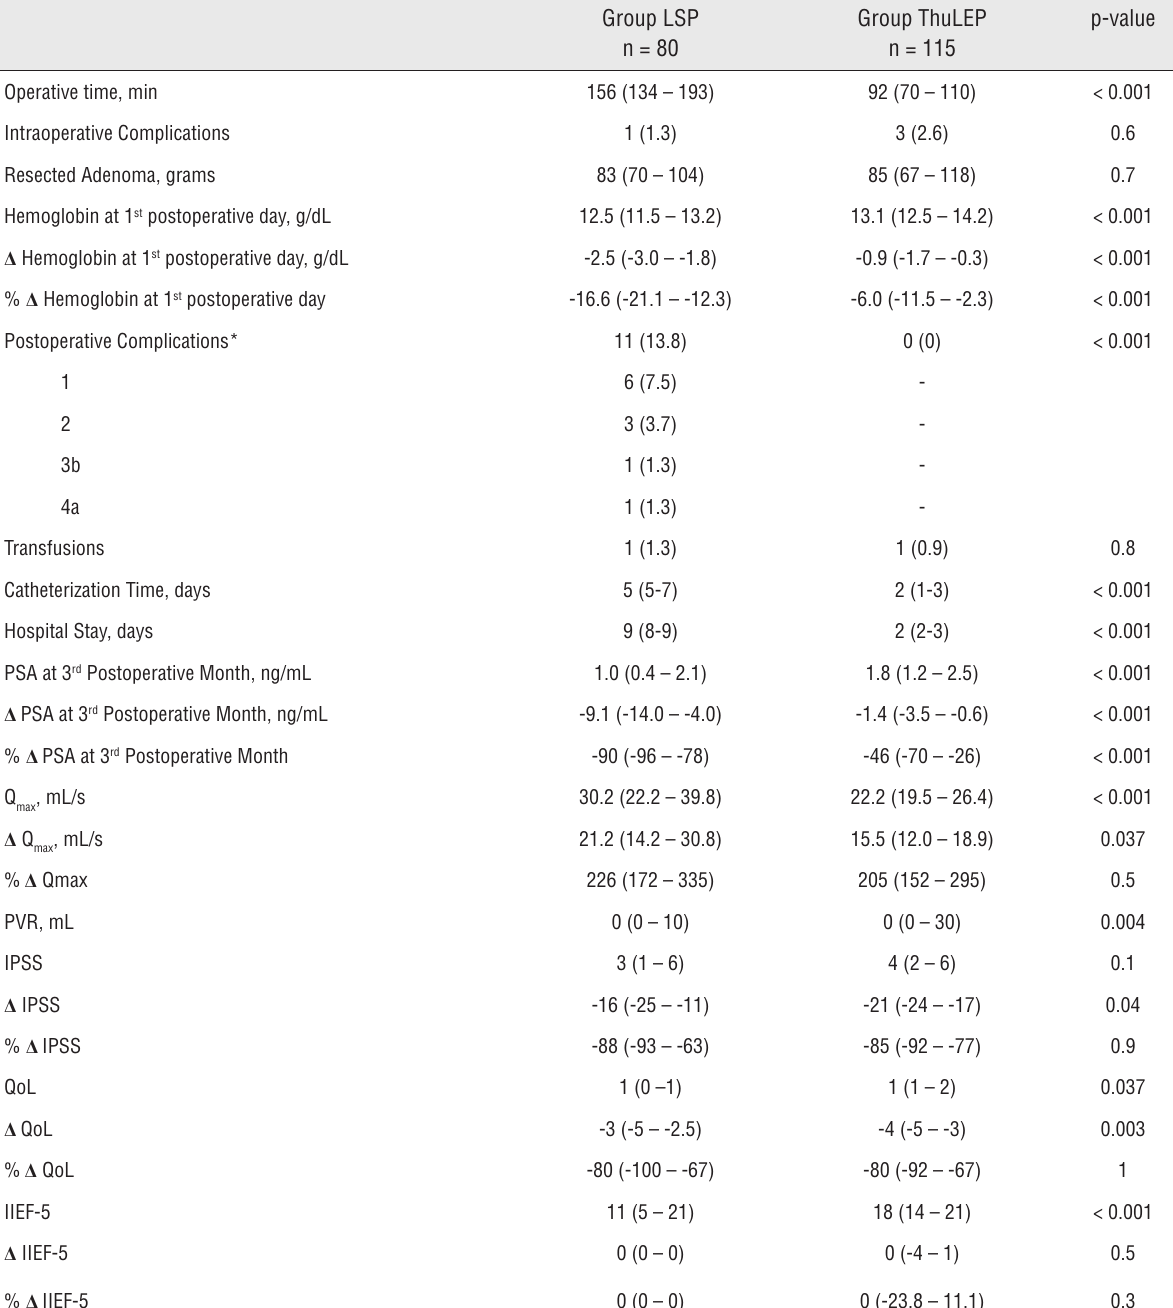
Group LSP Group ThuLEP p-value n = 80 n = 115